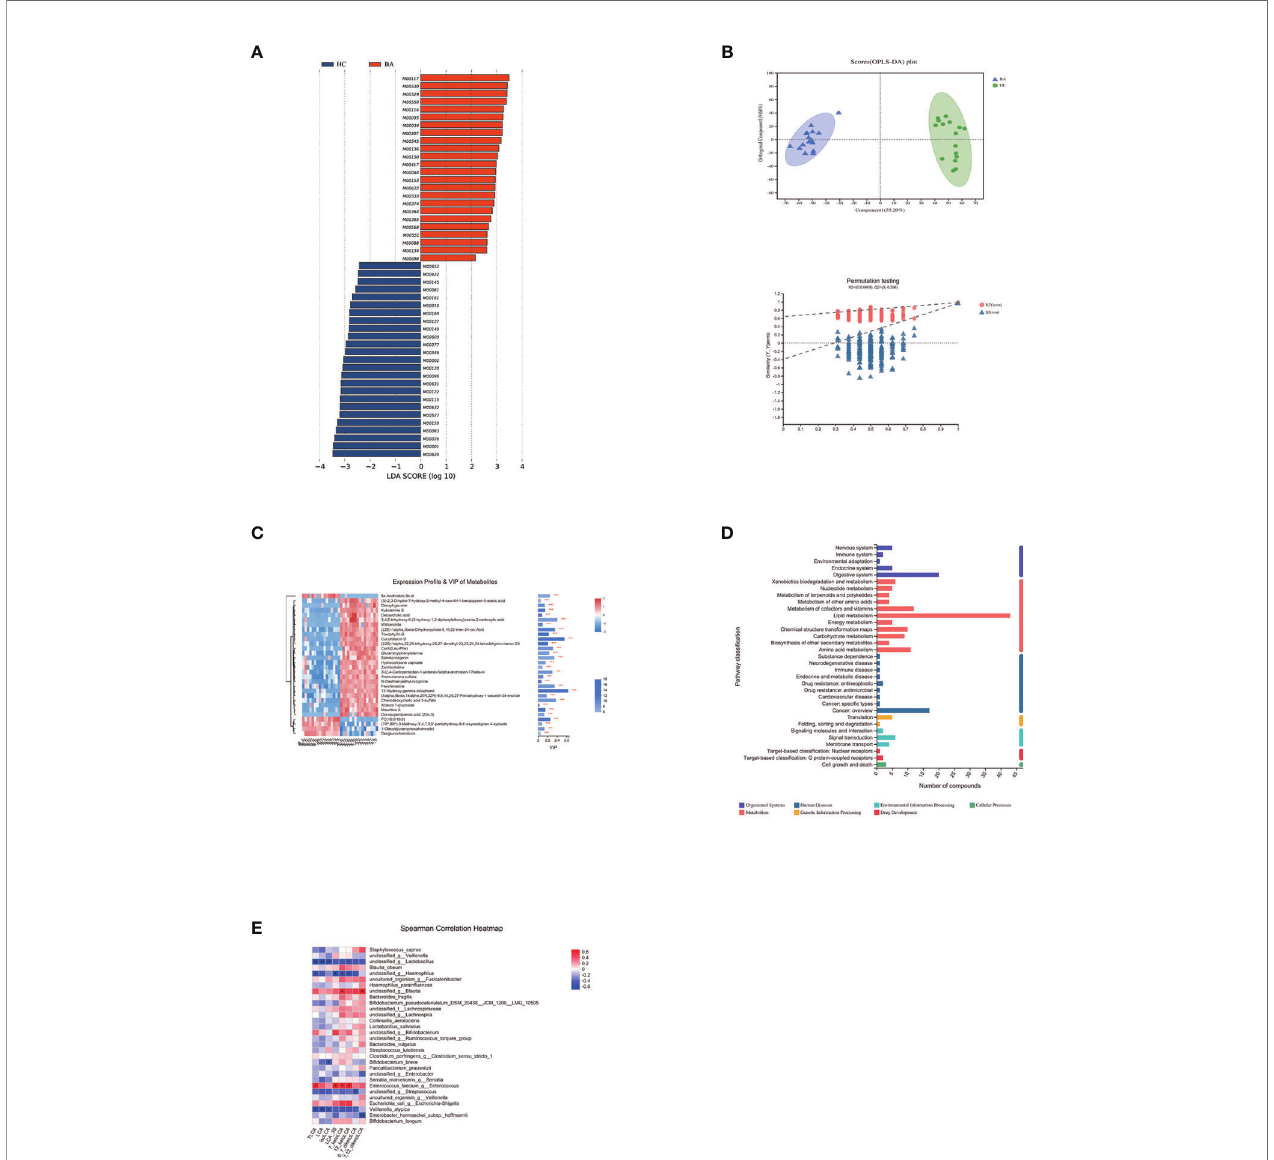
FIGURE 3 | (A) LEfSe analysis of gut microbiota functional pro fi les between the control and biliary atresia groups (BA, biliary atresia; HC, controls). Histogram of the LDA scores calculated for a differential abundance of functional pro fi les in the two groups. LDA score cutoff of 2.0 indicated a signi fi cant difference. Different colors represent different groups. (B) Signi fi cant differences in metabolite composition between the biliary atresia and control groups identi fi ed by OPLS-DA (above: OPLS- DA map; below: model veri fi cation map of OPLS-DA; BA: biliary atresia; HC: controls). OPLS-DA map: the fi rst prediction of Comp1 is mainly the decomposition degree, and the fi rst orthogonality of orthogonal Comp1 is the decomposition degree. Model veri fi cation map of OPLS-DA: the x-axis represents the replacement retention of the replacement test; the y-axis represents the R2 (red dot) and Q2 (blue triangle) replacement test values. The two dashes represent the regression lines of R2 and Q2, respectively. (C) Heatmap of differential metabolites between the two groups (VIP > 2, p < 0.05). The color represents the relative abundance of the metabolites in the samples. On the right is the VIP bar graph of metabolites. The length of the bar represents the contribution value of the metabolite to the difference between the groups (* p < 0.05, ** p < 0.01, *** P < 0.001). (D) KEGG pathways on level 1 and level 2 are related to differential metabolites. The ordinate is the name of pathway level 2, and the abscissa is the number of metabolites related to the pathway. Different colors represent different pathways on level 1. (E) Associations of differential lithocholic acid and derivatives with top 30 genera in abundance. The depth of the color indicates the correlation between species and environmental factors. Blue denotes negative correlation and red positive correlation (* p < 0.05, ** p < 0.01, *** p <